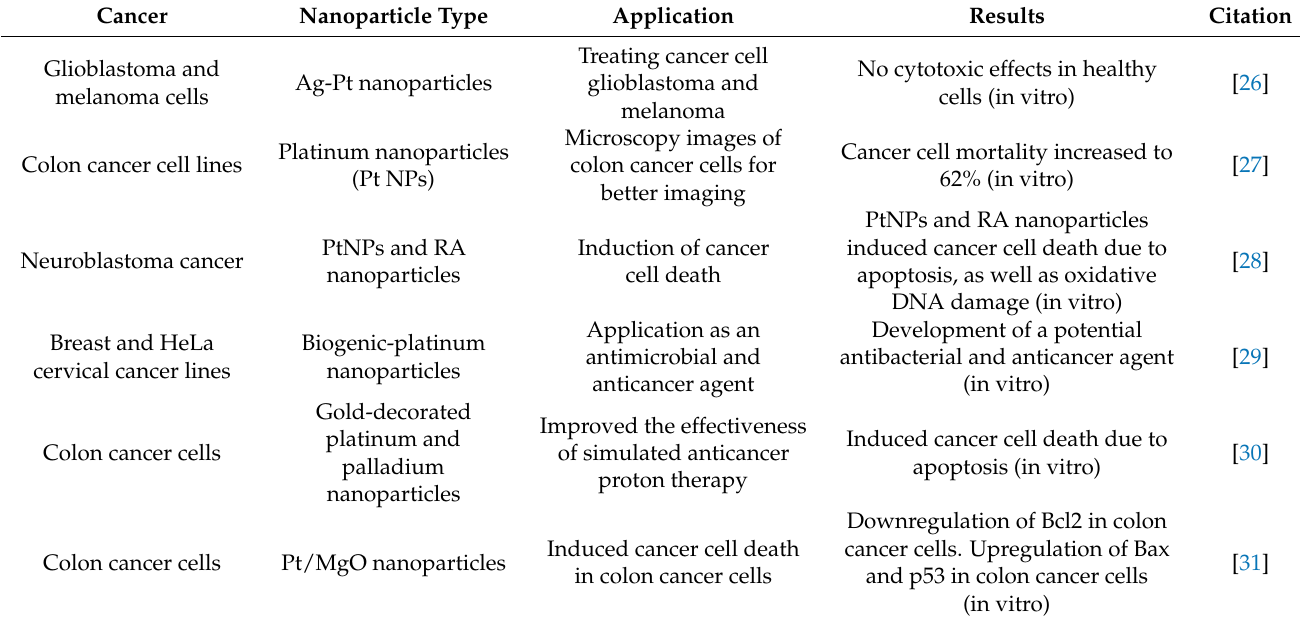
Table 2. Application of platinum-based nanoparticles in various types of cancer